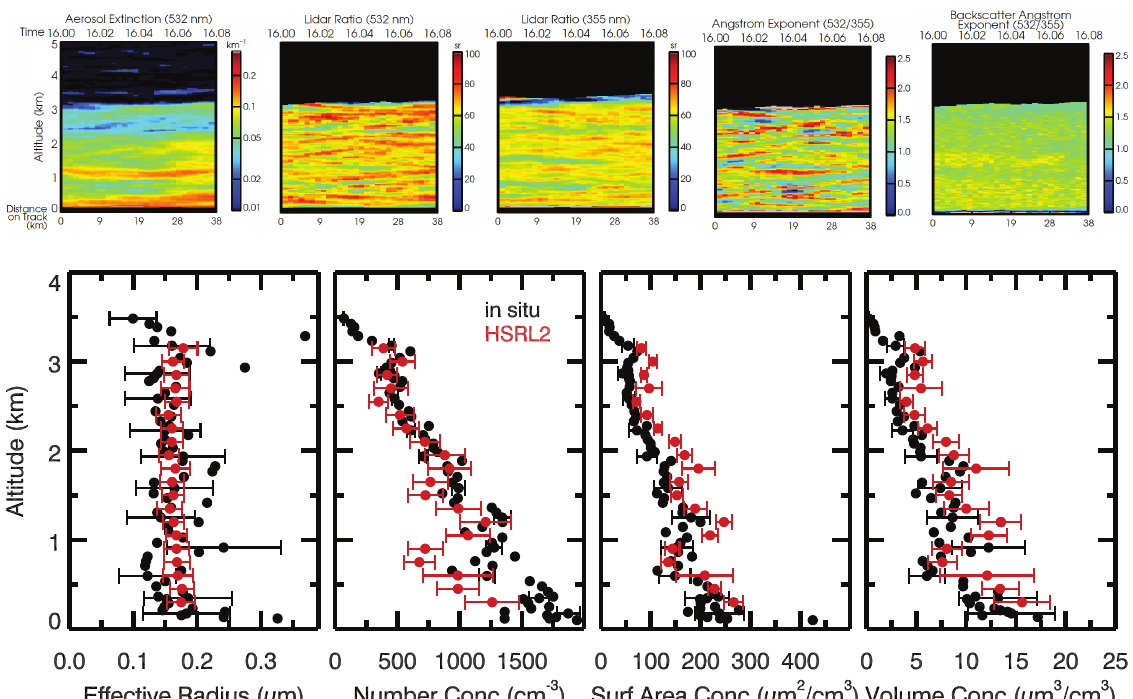
Figure 4. (Top) Curtain plots of an 5min flight segment that was used for the data inversion. (Bottom) Microphysical parameters retrieved from the inversion method (red) and from the G-1 in situ measurements (black) on 17 July 2012. The measurement time was 16:00– 16:05UTC for the inversion results and 15:45–15:56UTC for the in situ data. The lidar measurements were obtained 2km from the approxi- mate G-1 spiral center. The inversion results represent height intervals of 150m. The in situ data were taken with considerably higher spatial resolution. Error bars of the individual in situ data points are composed of two types, counting and sizing. The error bars denote 1 standard